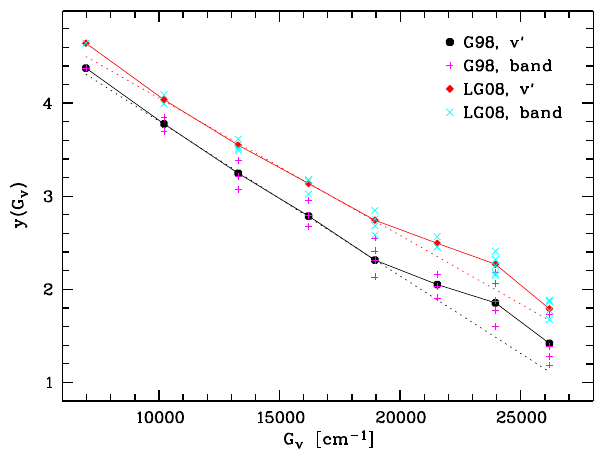
Figure 7. Derivation of OH T vib under the assumption of a Boltz- mann distribution for the different v (cid:48) . The abscissa shows the en- ergy of the lowest rotational level G v of the vibrational level v (cid:48) in cm − 1 . The ordinate displays the natural logarithm of the popula- tion of a hyperfine-structure level of the lowest rotational level of v (cid:48) relative to 1 Rayleigh second. The intensities of the OH lines origi- nating from higher rotational levels were corrected by means of the v (cid:48) -related T rot (see Fig. 6) to correspond to the rotational ground state of X 2 (cid:53) 3 / 2 . The “+” and “ × ” symbols show the mean values of y(G v ) for each OH band for the G98 and LG08 line parame- ters, respectively. The averaged y(G v ) from all lines with fixed v (cid:48) are displayed by filled black circles and red diamonds and are con- nected by solid lines. The dotted lines represent linear fits to the averages for v (cid:48) = 3 to